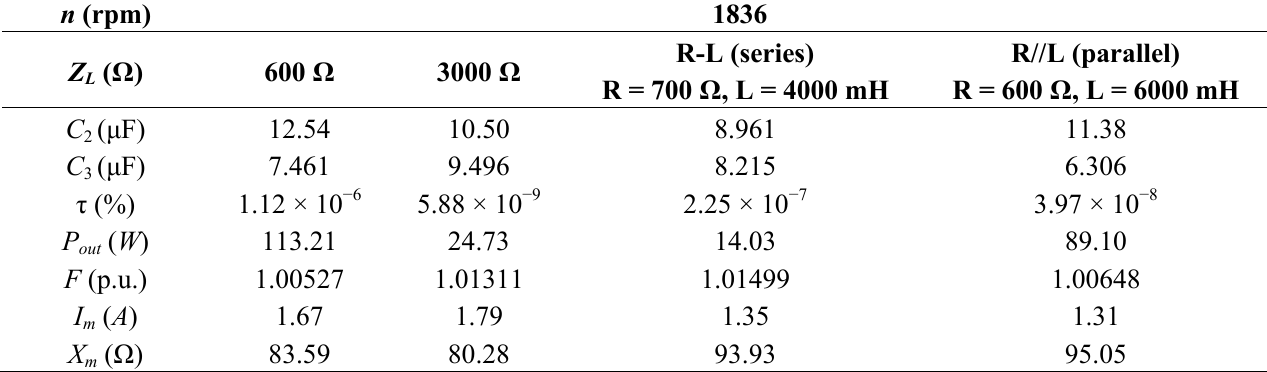
and C for different load impedances at a speed of n = 1836 2 3